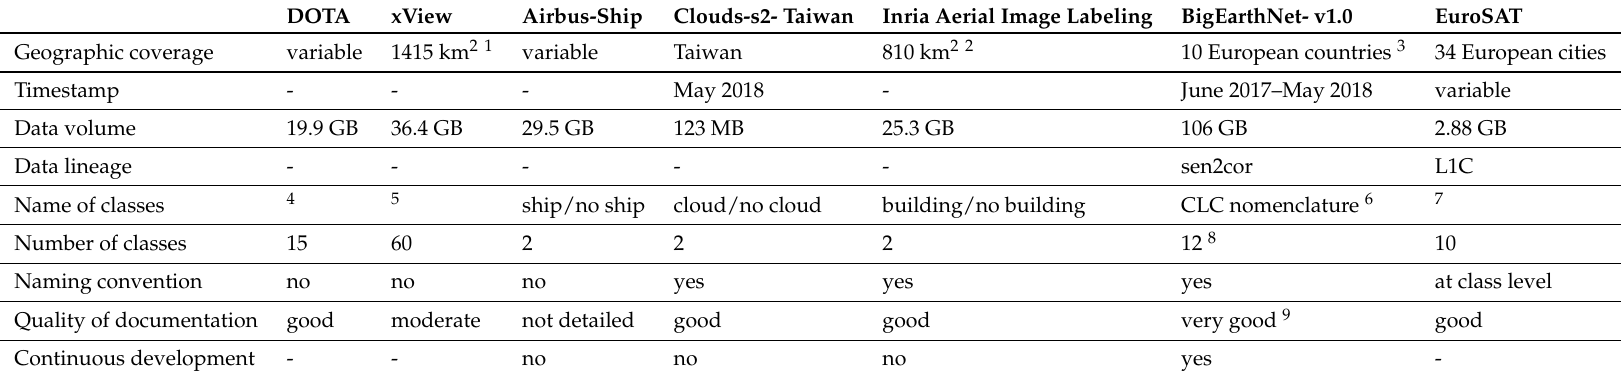
Table 2. Attributes related to the usage and sustainability of the training